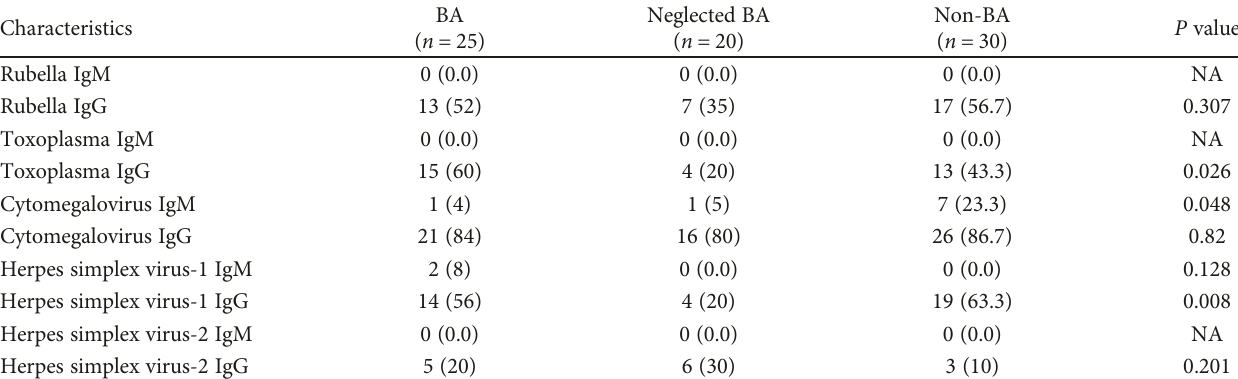
Table 3: Toxoplasma and viral infections in the studied groups.